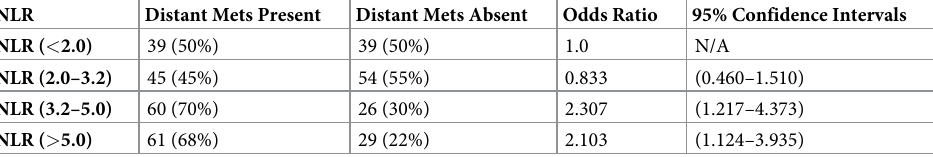
Table 4. The association between NLR (categorical variable) and the presence of baseline distant metastases. NLR Distant Mets Present